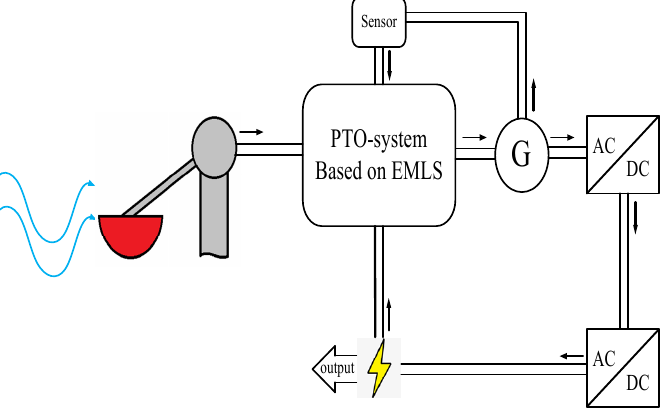
Figure 12. Overview of energy conversion with proposed EMLS.